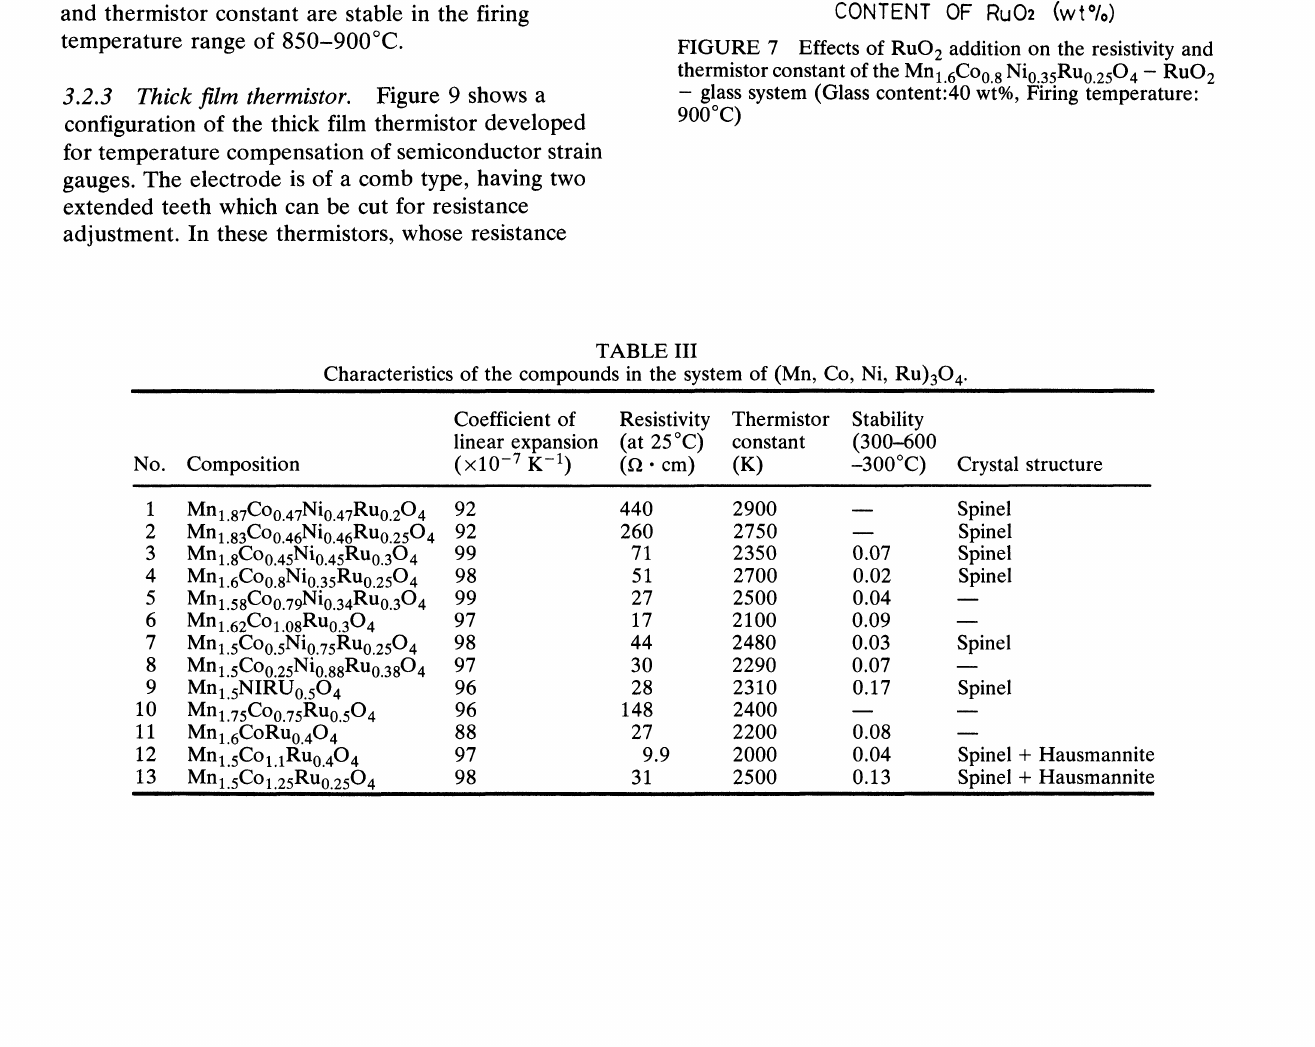
2 addition on the resistivity and 4